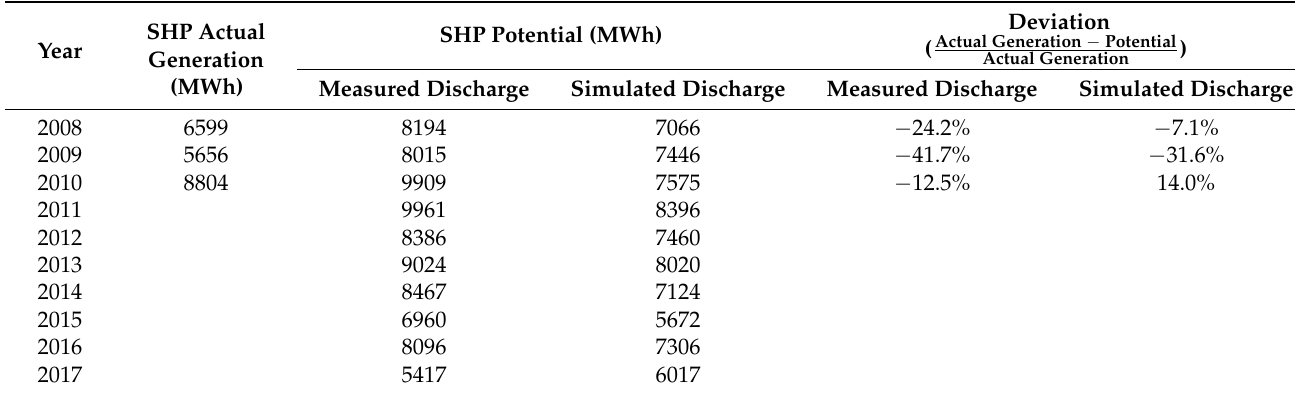
Table 14. Annual SHP potential result for the Socheon SHP